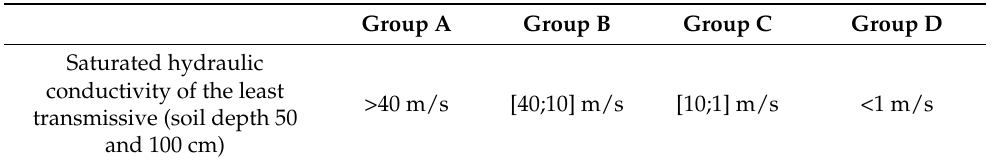
Table 2. Soil hydraulic conductivity parameters. Source: InVEST User’s Guide available at: https://invest-userguide.readthedocs.io/en/latest/urban_flood_mitigation.html accessed on 14 January 2023.